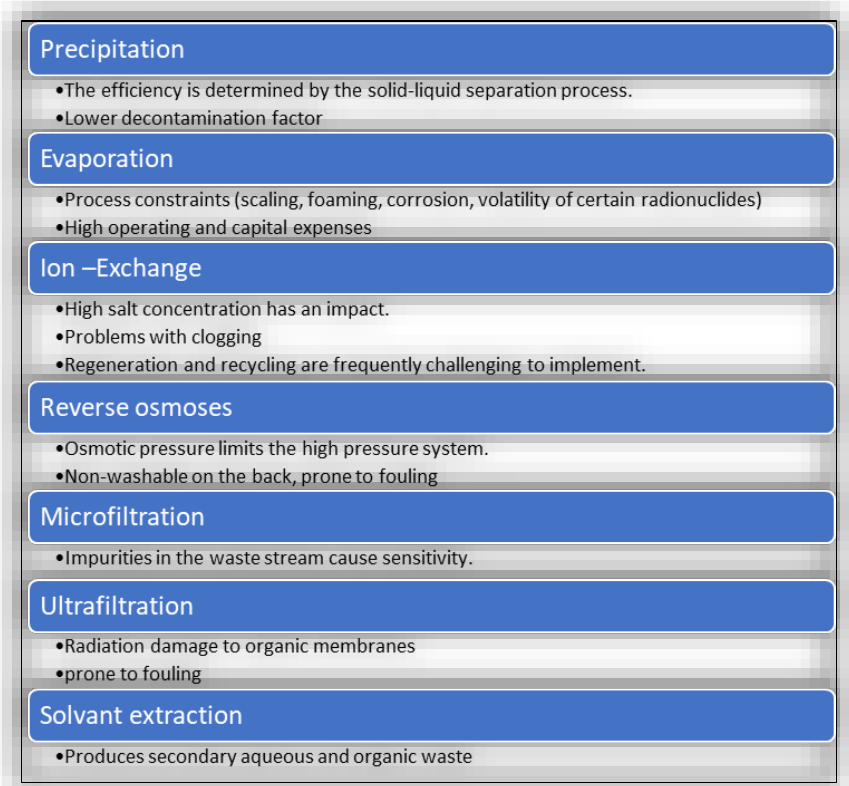
Figure 5. The limitations of various aqueous liquid treatment solutions.